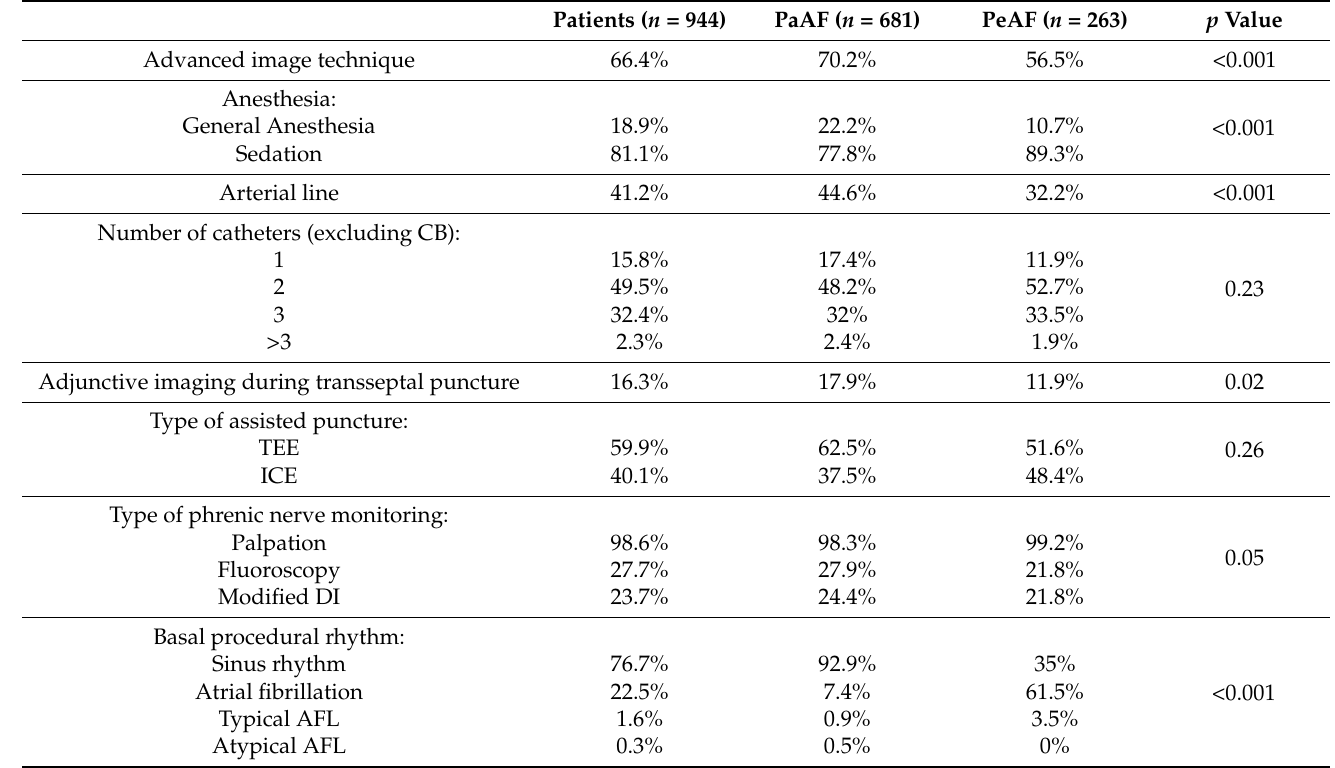
Table 2. Procedural Characteristics: Paroxysmal vs.